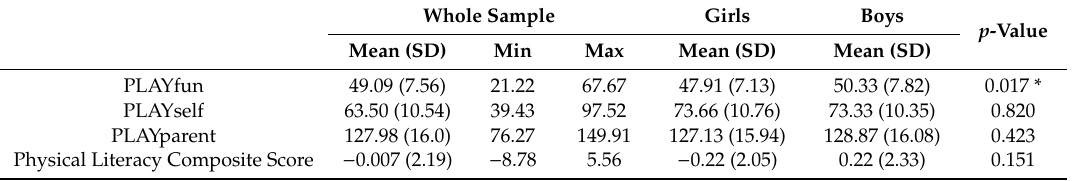
Table 2. PLAYfun, PLAYself, PLAYparent, and physical literacy composite scores.